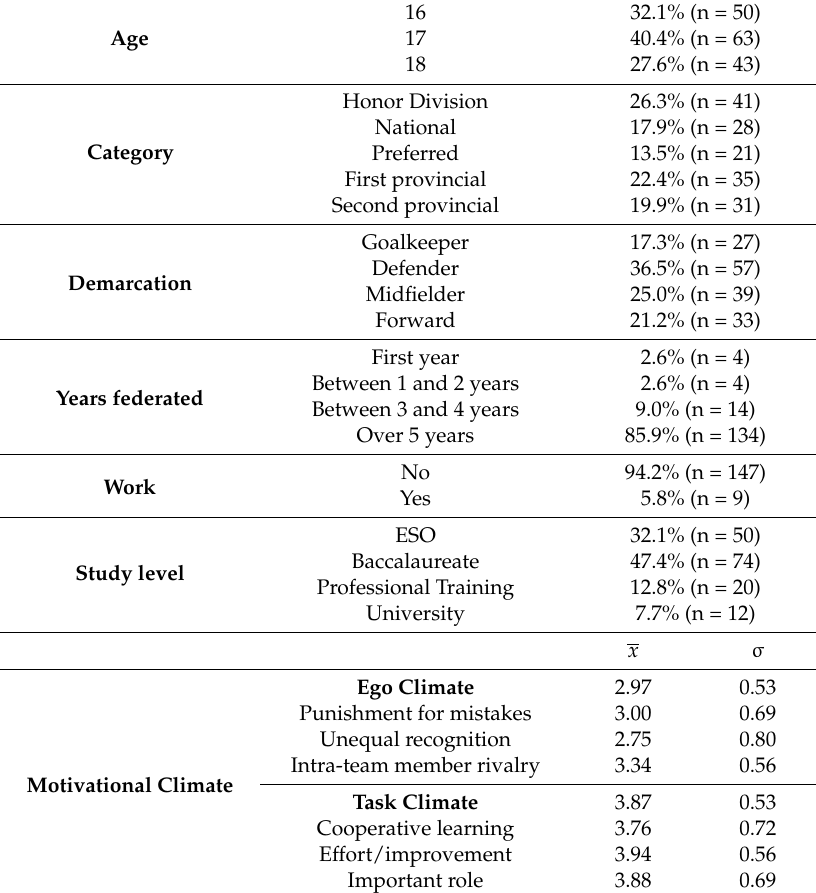
Table 1. Descriptive analysis.